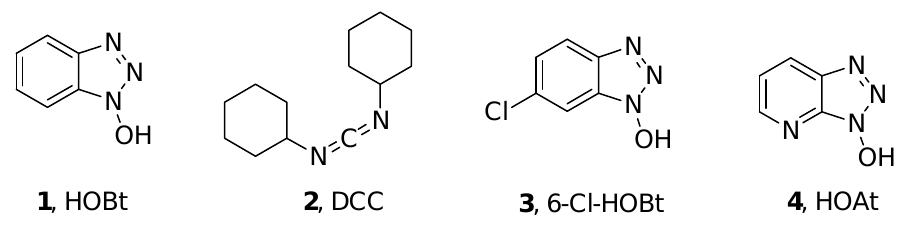
Figure 1. Structure of additives and DCC.